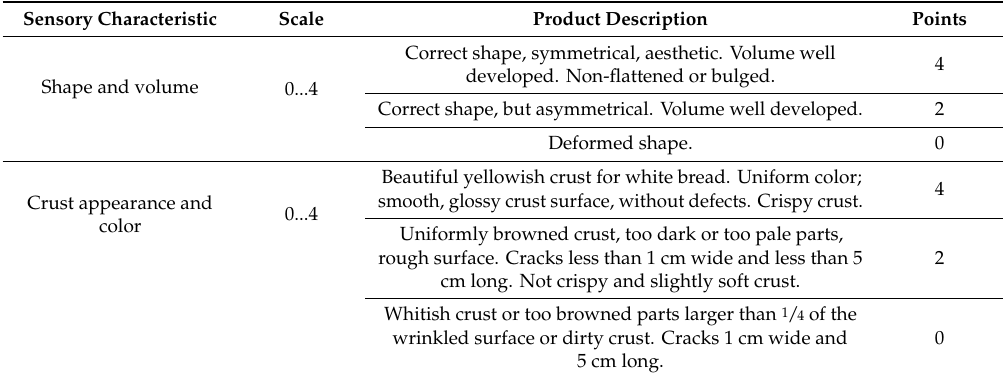
Table 6. Criteria for sensory evaluation of wheat